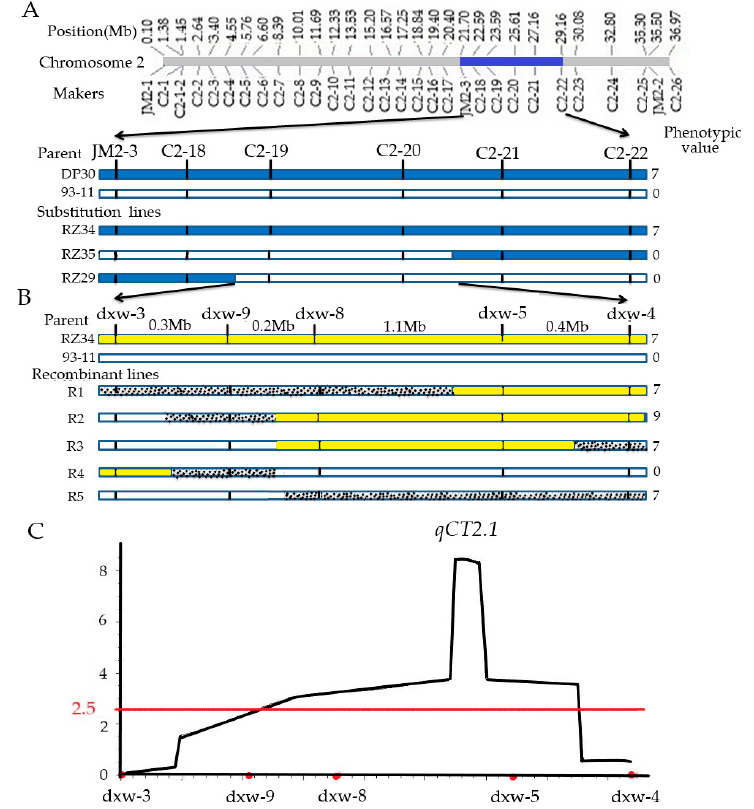
Figure 7. Mapping of grain-shattering QTL qCT2.1 , ( A ) QTL analysis by overlapping segments of recombinants RZ34, RZ35 and RZ29, blue intervals indicate DP30 genotype; blank intervals indicate: 93-11 genotype; shadow intervals indicate heterozygous genotype; ( B ) linkage analysis of qCT2.1 yellow intervals indicate RZ34 genotype, blank intervals indicate 93-11 genotype, shadow intervals indicate heterozygous genotype; ( C ) LOD value of qCT2.1. dxw-3, dxw-8, dxw-9, dxw-5 and dxw-4 are InDel markers.